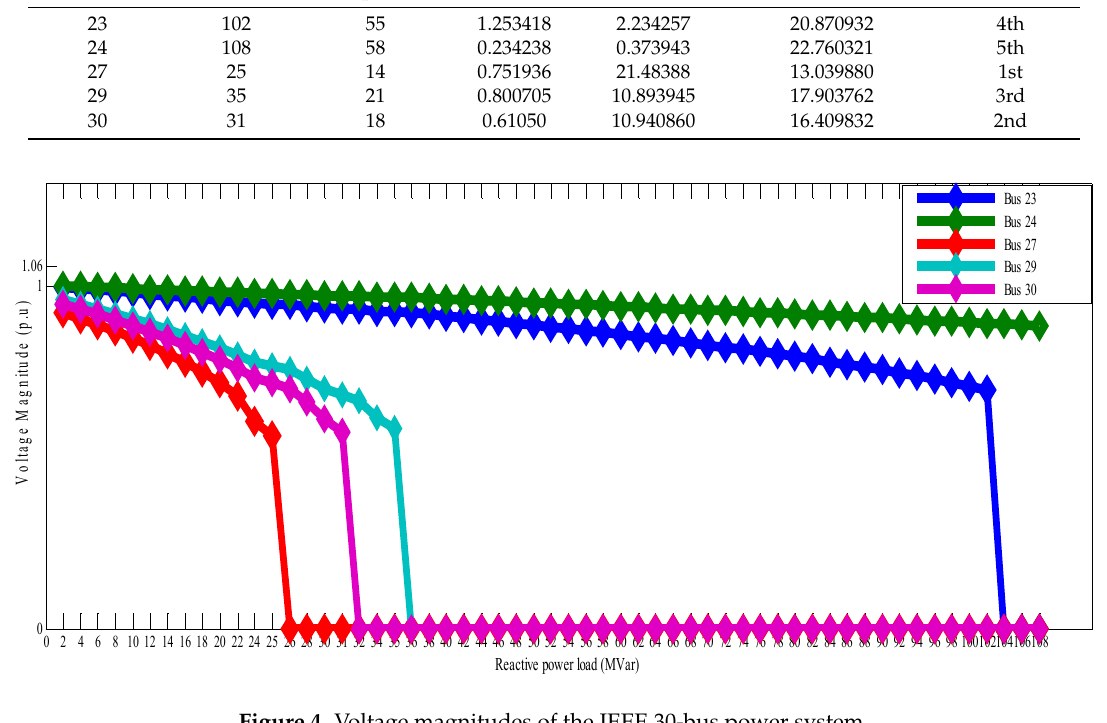
Figure 4. Voltage magnitudes of the IEEE 30-bus power system. Table 7. Results of the CMAT for the IEEE 30-bus power